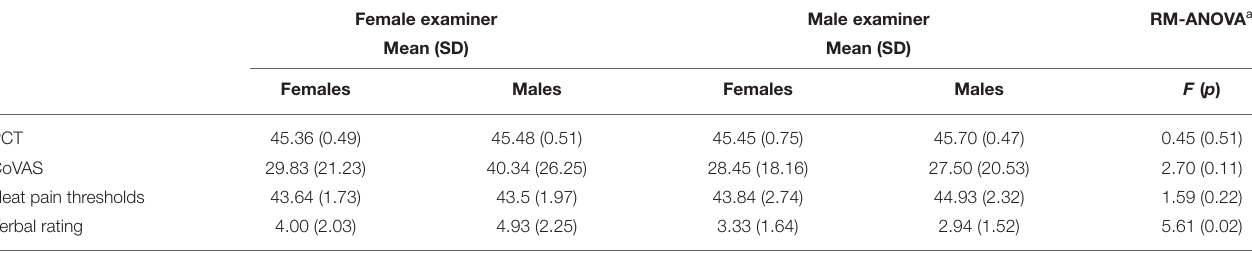
TABLE 1 | Means and standard deviations and results of the repeated measures ANOVA tests, separated by male and female participants and examiners. ANOVA output for interaction effect presented. Female examiner